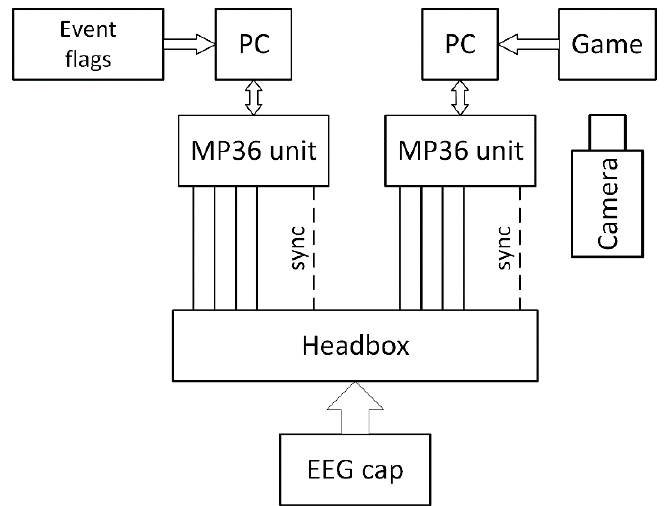
Figure 3. Arrangement of the eight-channeled EEG system.